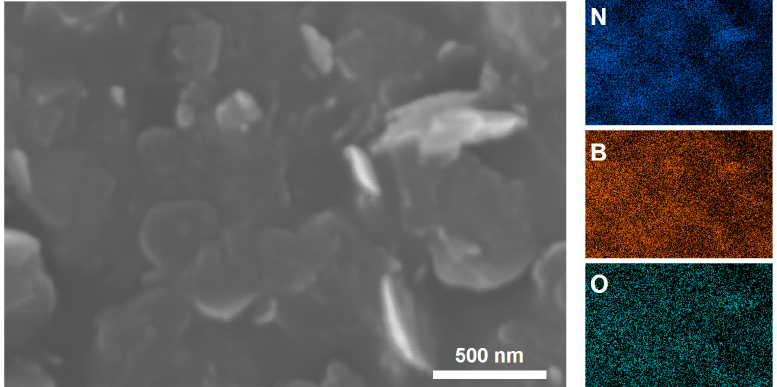
Figure 3. EDS mapping of N, B and O elements in BNNSs-OH@500.